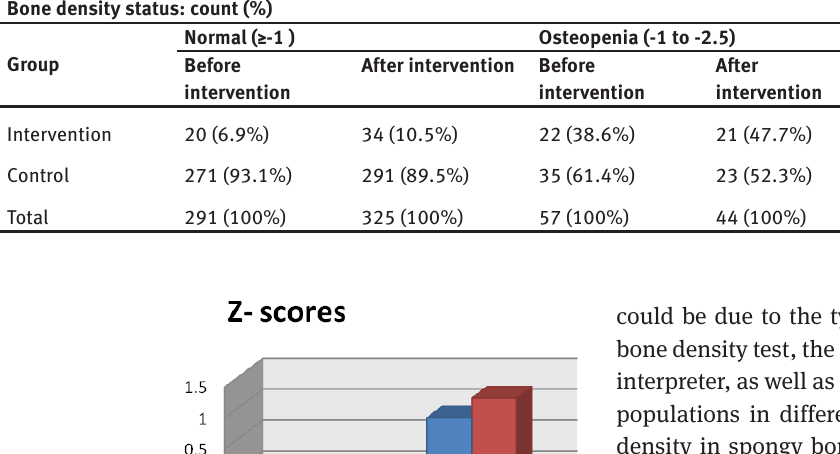
Bone density status: count